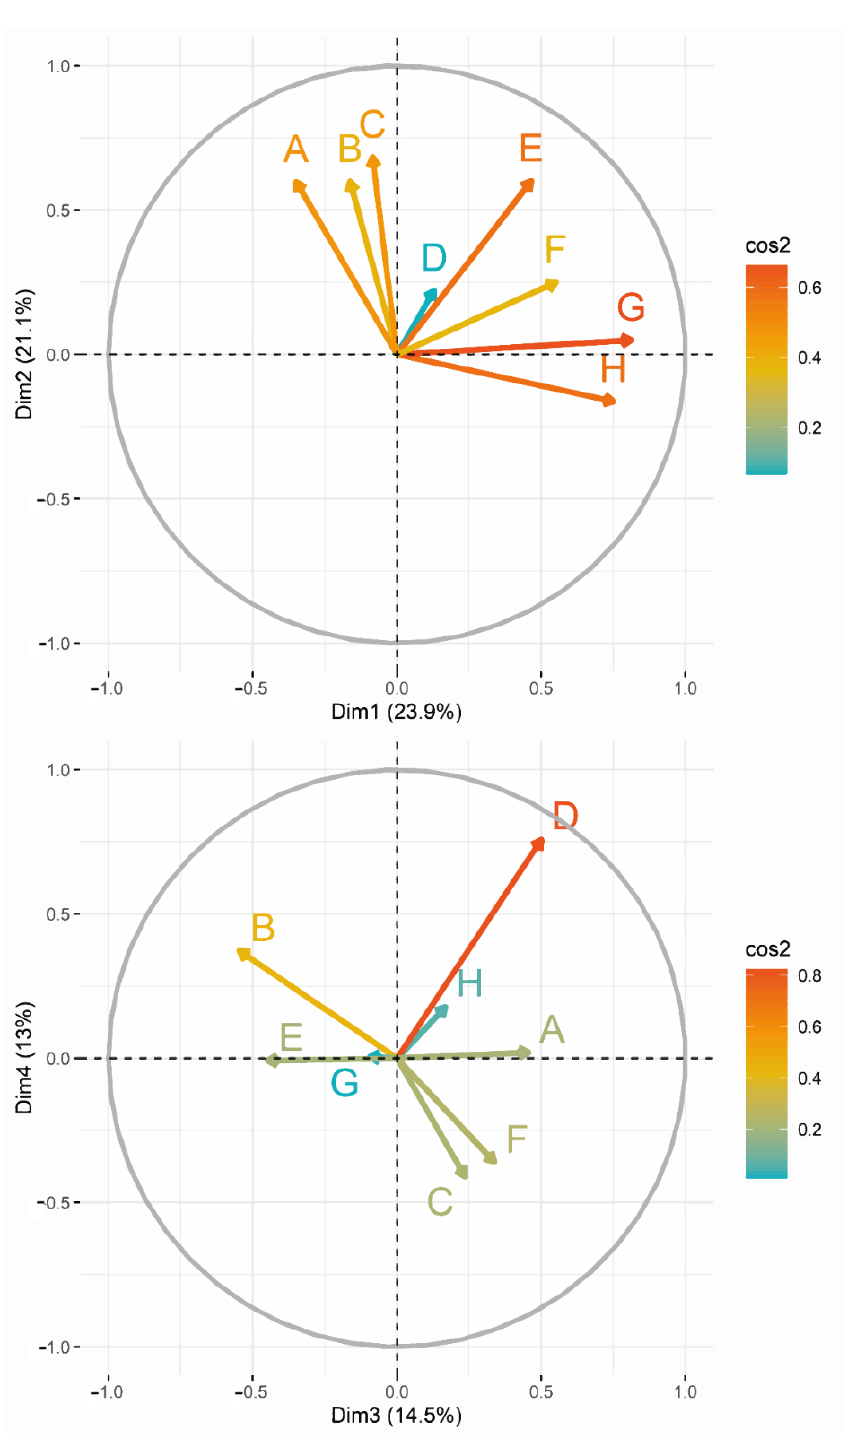
Figure A1. Variables factor maps on four dimensions (GDD – PCA). The factors are colored according to their quality of representation (A = rate of non-invasive samples; B = number of samples per individual per year; C = number of sex markers used; D = total number of samples gathered; E = number of STRs used; F = number of calculations done regarding the Genetic Diversity and other Dynamics (GDD); G = number of types of sample used; H = time of study).